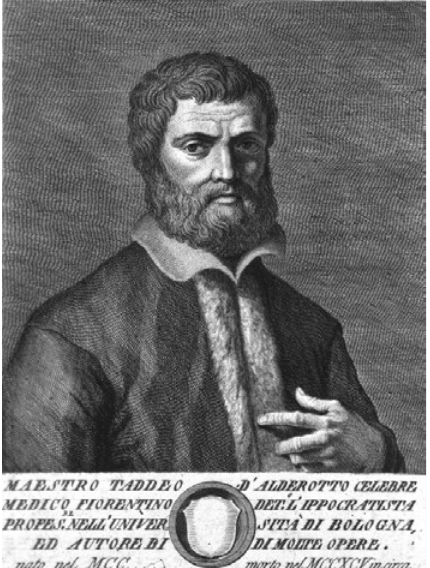
Figure 2. Engraving of Taddeo Alderotti of Florence (ca. 1210- 1295) [ The National Library of Medicine